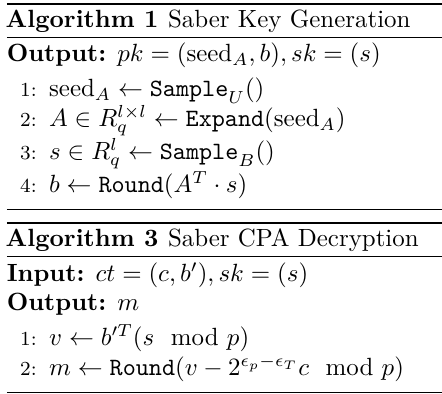
Algorithm 1, Algorithm 2, and Algorithm 3 depict the CPA-secure key